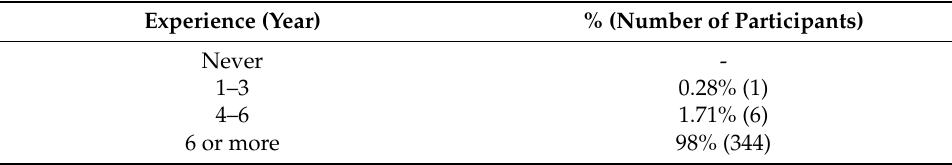
Table 17. Experience with mobile application information.